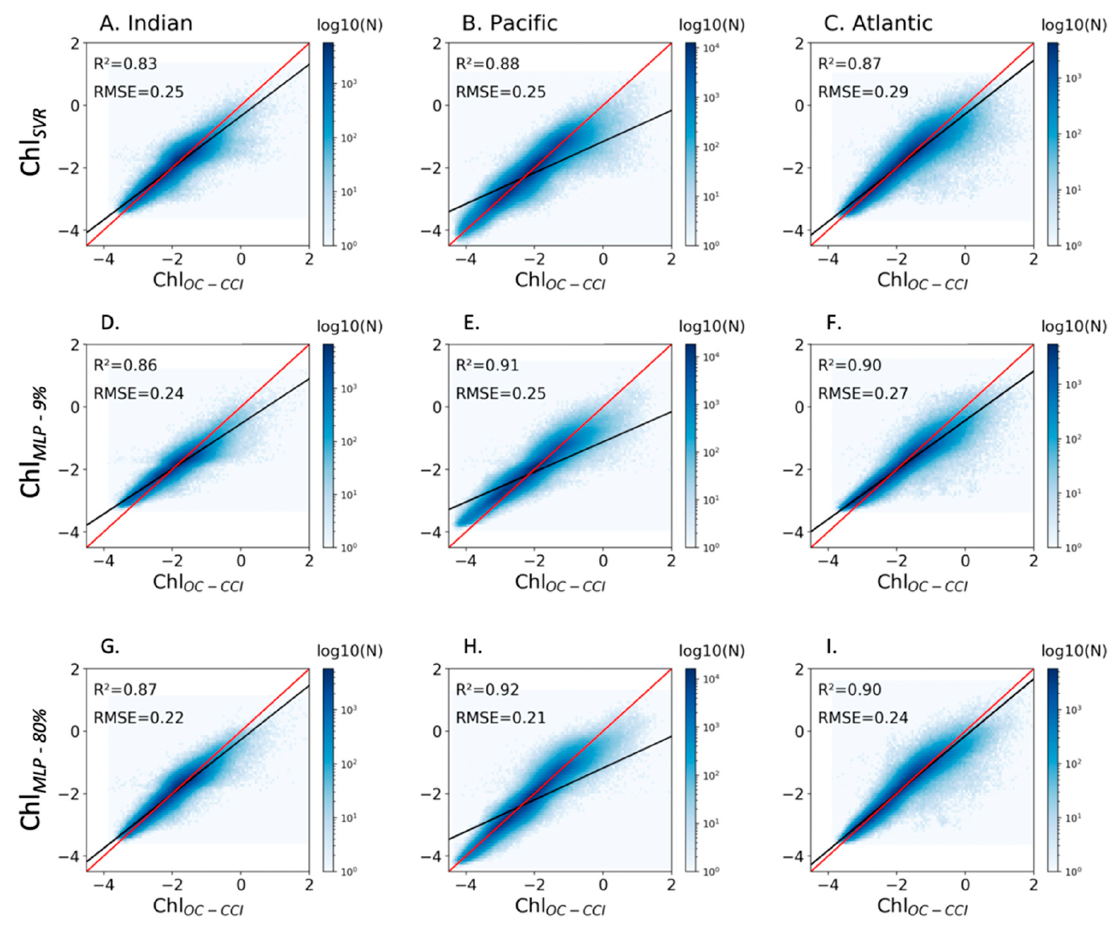
Figure 2. Scatter plots of log of Chl OC-CCI vs. ( A – C ) Chl SVR , ( D – F ) Chl MLP-9% and ( G – I ) Chl MLP trained on 80% of the dataset, for each oceanic basin between 50° S and 50° N and over 1998–2015. The Chl OC-CCI vs. reconstructed Chl regression lines are plotted in black and the 1:1 regression lines are plotted in red. The figure is color-coded according to the density of observations.